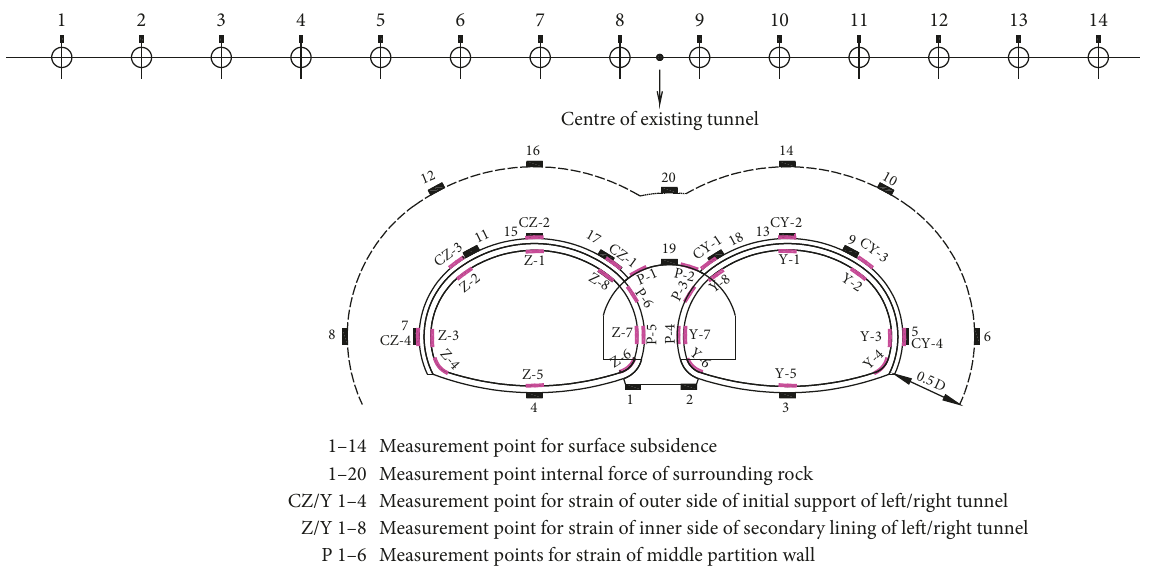
Figure 3: Arrangement of strain gauge measurement points for surrounding rock, lining, and middle partition wall.